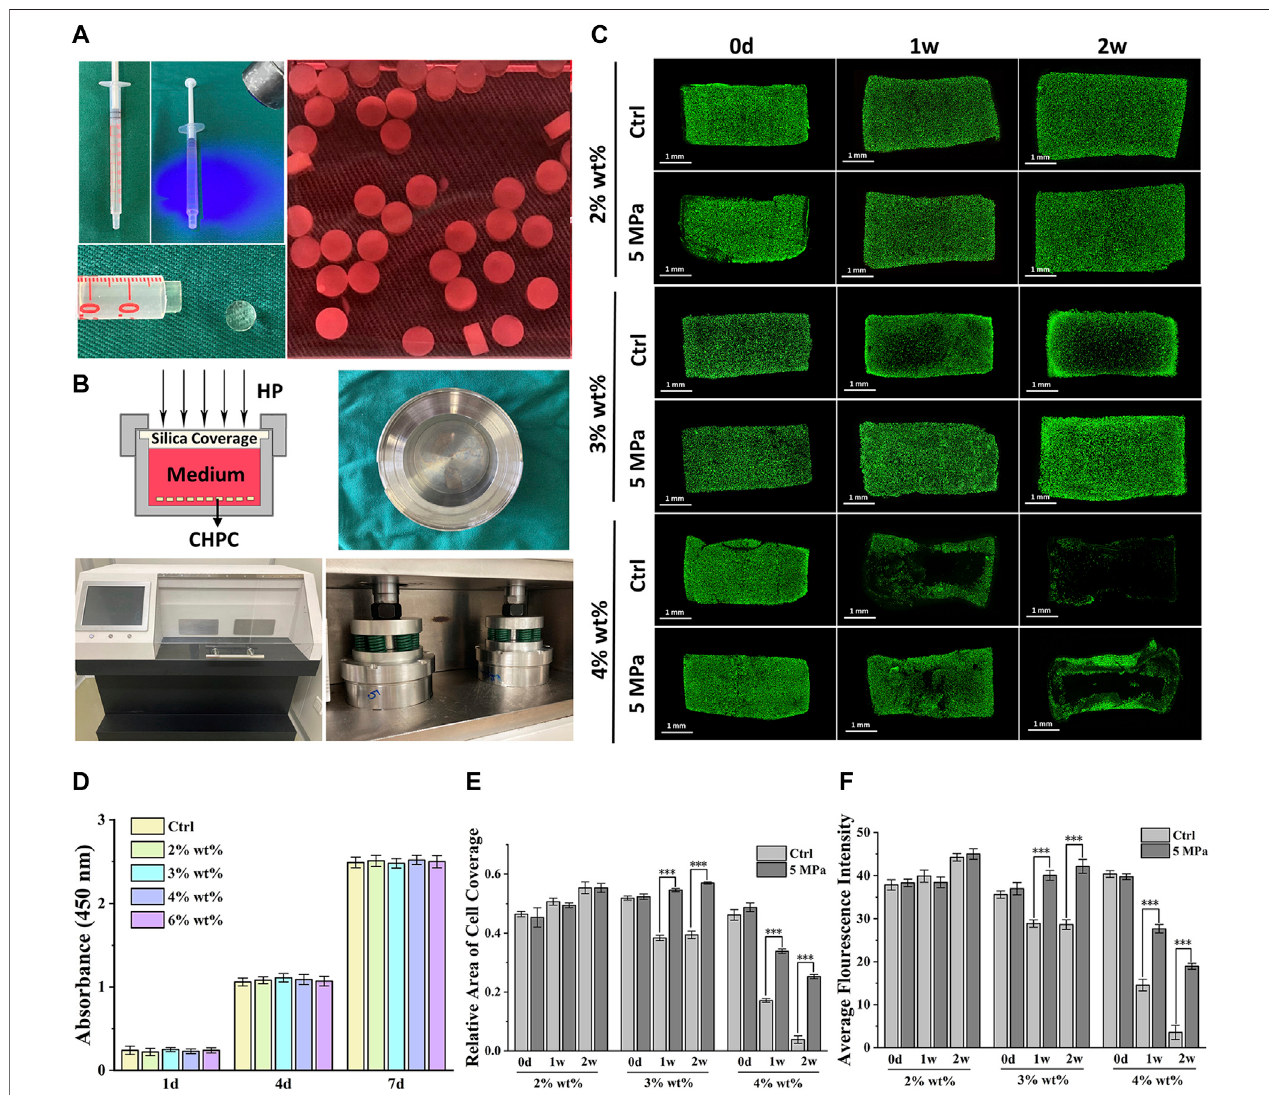
FIGURE 2 | Biological evaluation of CHPC with different hydrogel concentrations. (A) Preparation of CHPC. The HPC hydrogels mixed with chondrocytes were placed into asyringe, crosslinked by lightirradiation and cut into 2 mm cylinders, and cultured in the culture medium. (B) Schematic ofthe HP bioreactor, and images of the culture tank and HP machine. (C) Live and dead cell staining of CHPC after culturing for 0 days, 1 week, and 2 weeks (D) CCK-8 results of chondrocytes cultured in culture medium mixed with fi ve ‰ HPC hydrogels. HPC hydrogels of different concentrations in culture medium did not affect cell proliferation. (E – F) The relative area of live cells (E) and the average fl uorescence intensity (F) ( p < 0.001), the semi-quantitation results of Figure 2B .